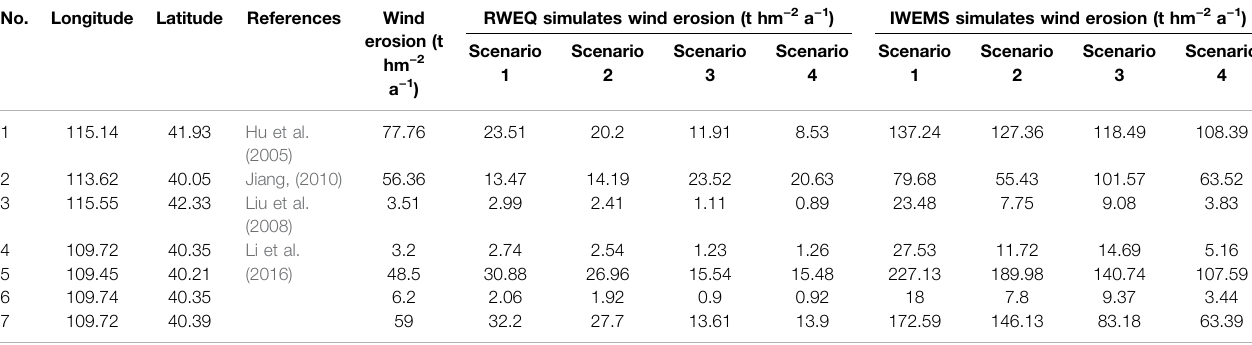
TABLE 4 | Comparison of wind erosion in sites among different